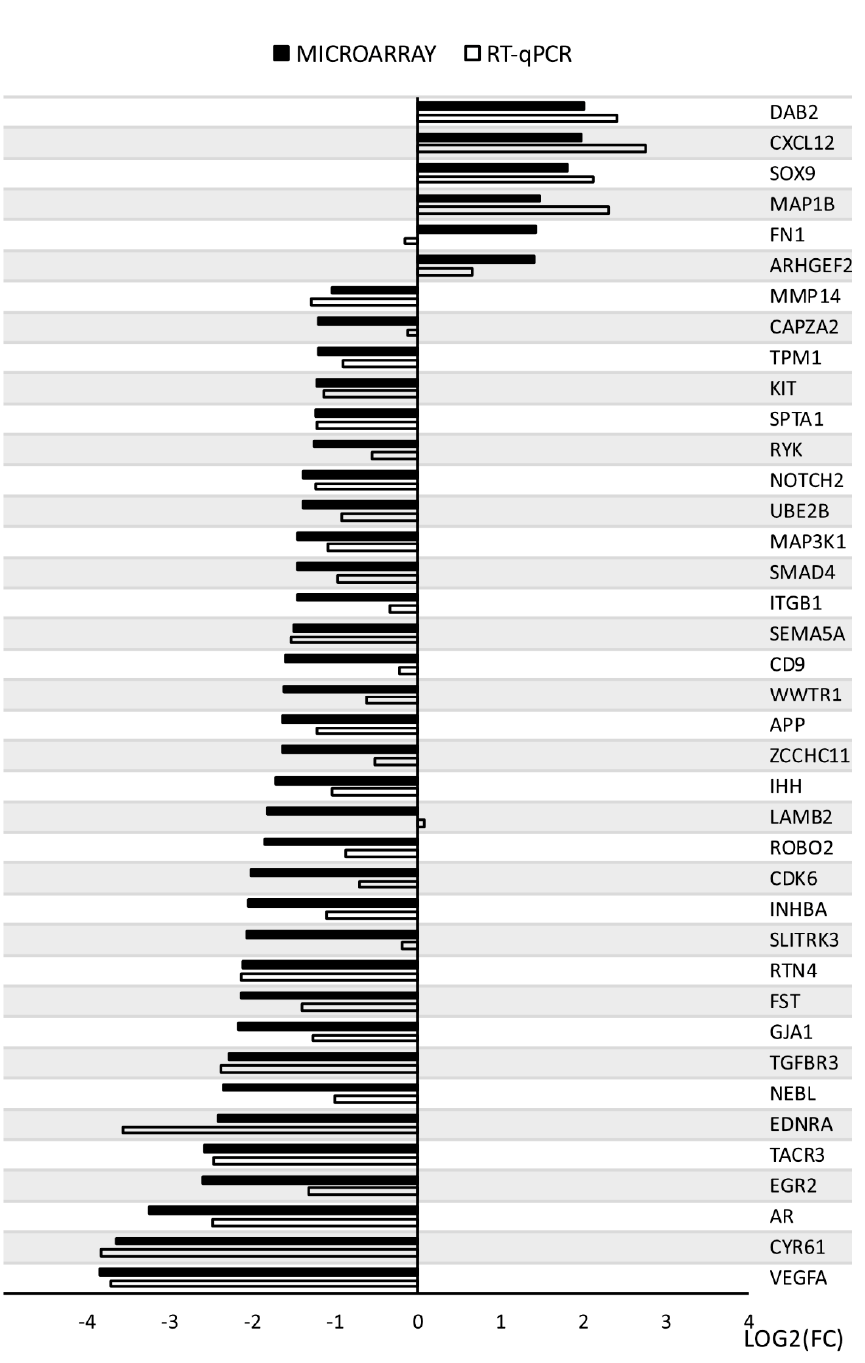
Figure 10. RT-qPCR—microarray validation.